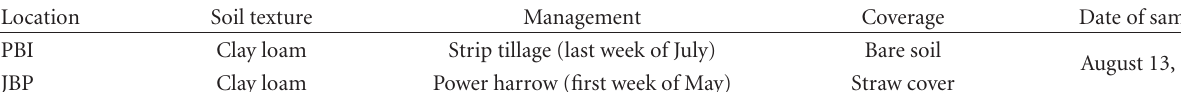
Table 1: Di ff erences in management practices for the experimental sites.